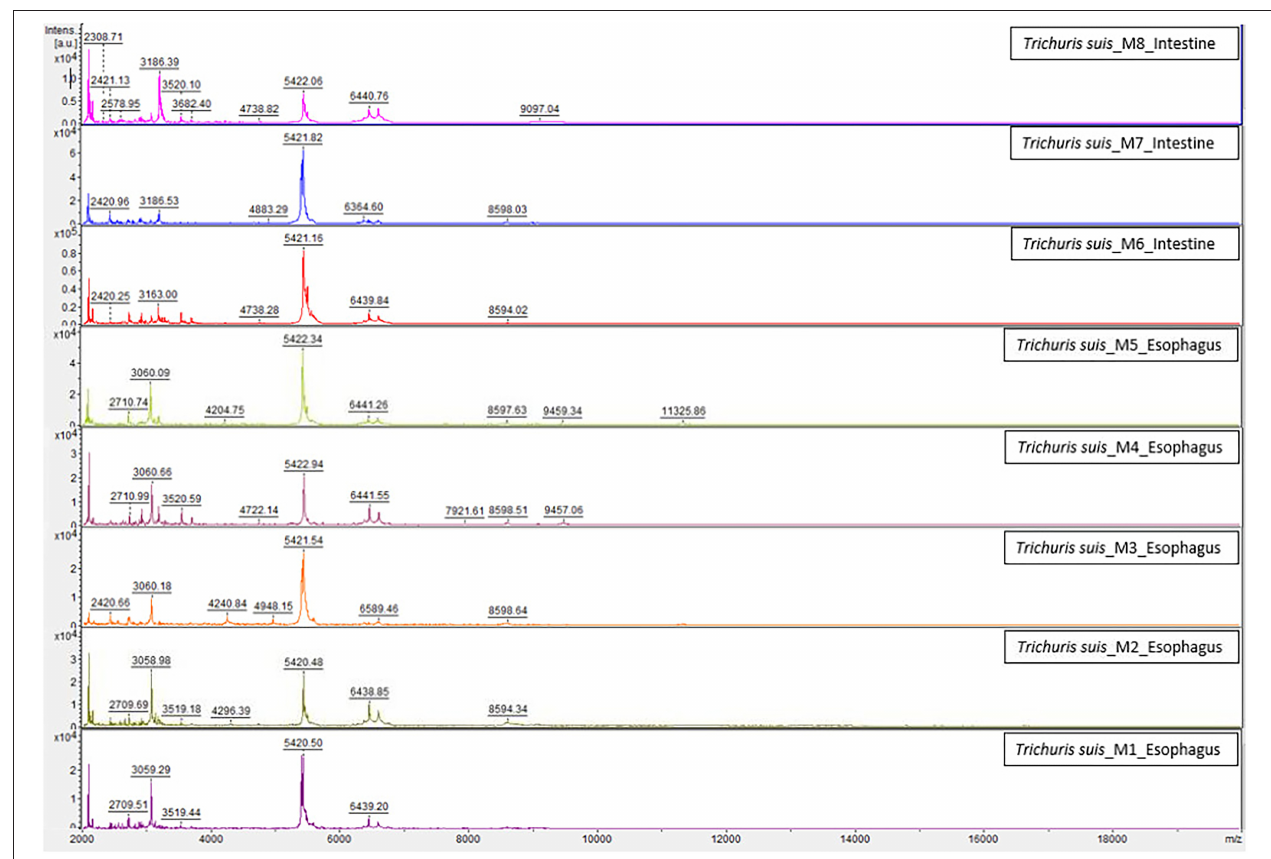
FIGURE 1 | Comparison of the spectra created for the internal database between esophagus and intestine samples of T. suis worms by MALDI-TOF MS. a.u., arbitrary units; m / z , mass-to-charge ratio (Da).